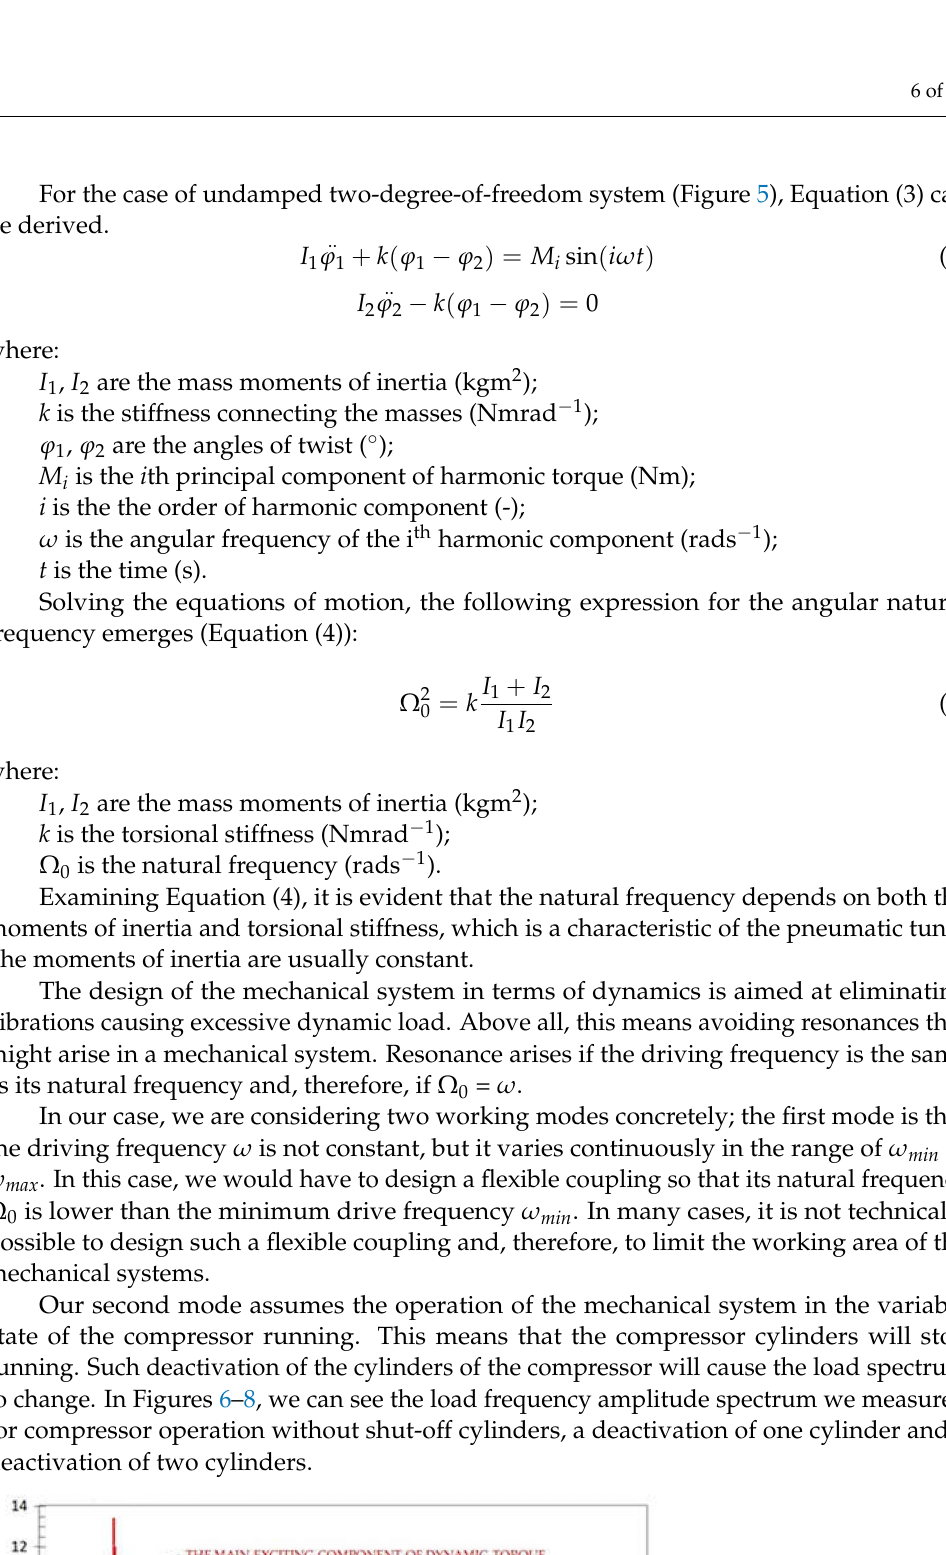
Figure 7. Frequency amplitude spectrum with deactivation of one cylinder in the compressor.